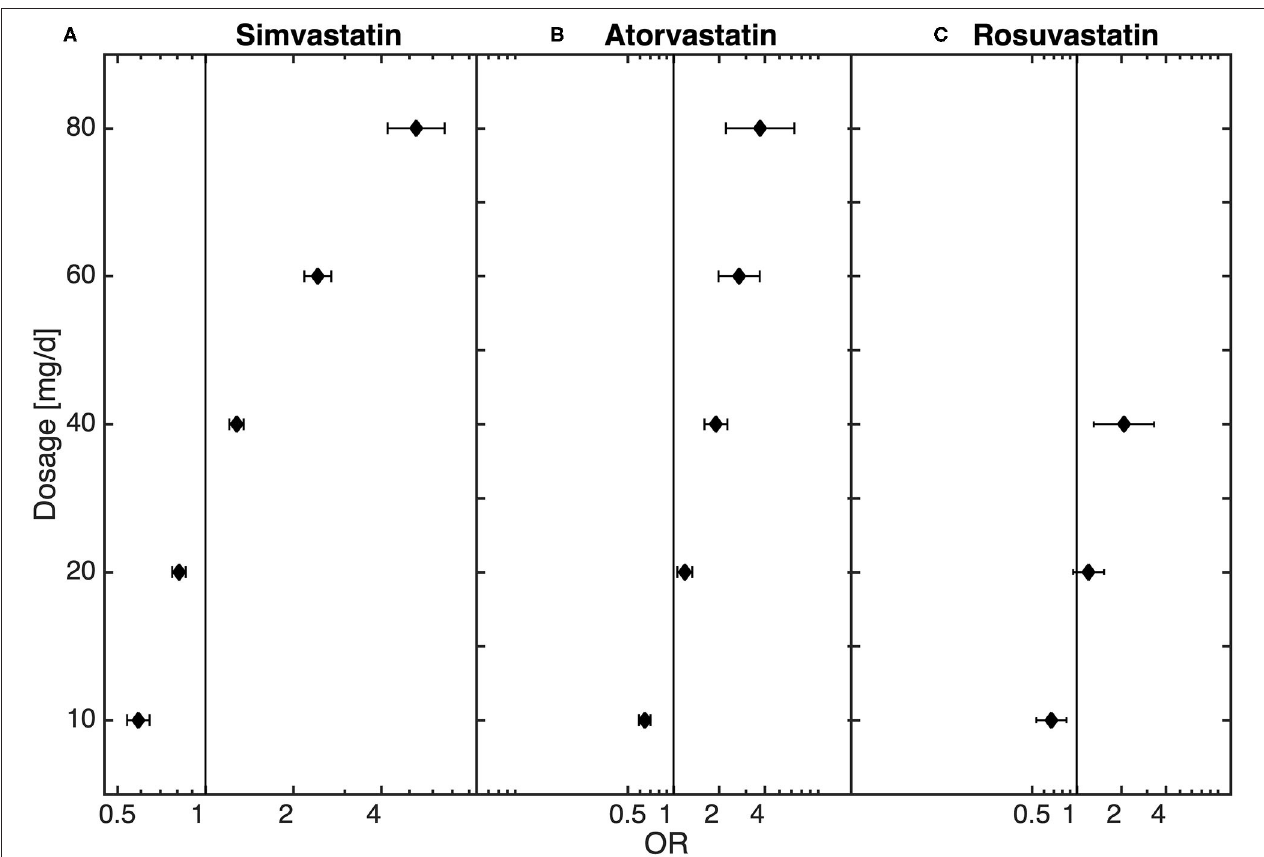
FIGURE 1 | Dose-dependent relationship between (A) simvastatin ( n = 214,021), (B) atorvastatin ( n = 37,919), (C) and rosuvastatin ( n = 8,209) and diagnosis of depression obtained from the logistic regression